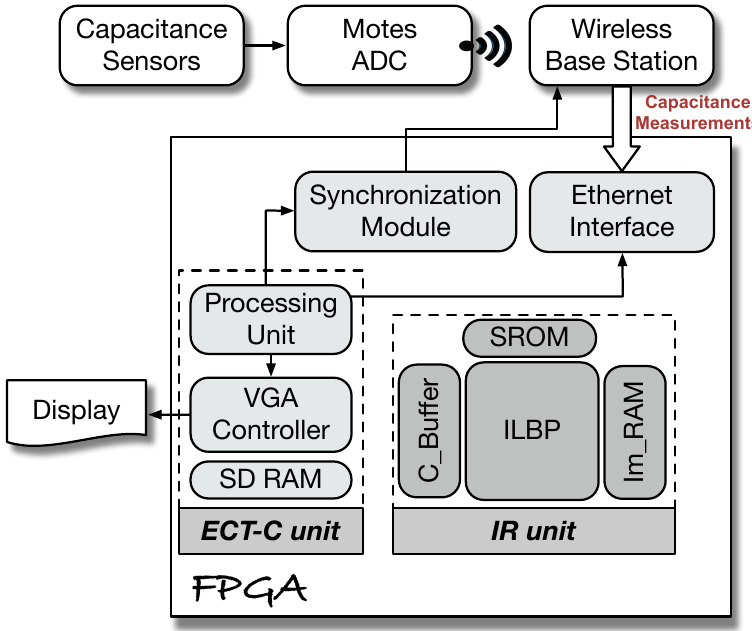
Figure 4. Block diagram of the proposed